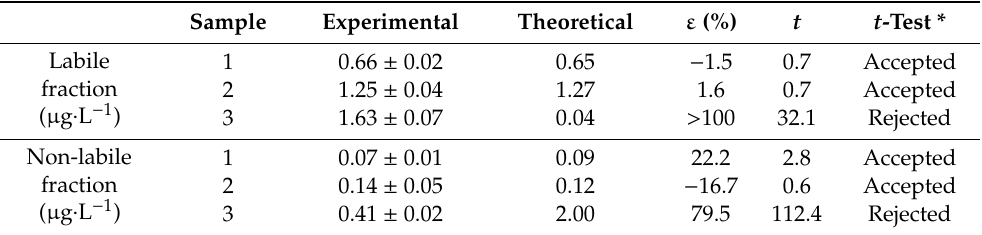
Table 4. Comparison between experimental and theoretical data.